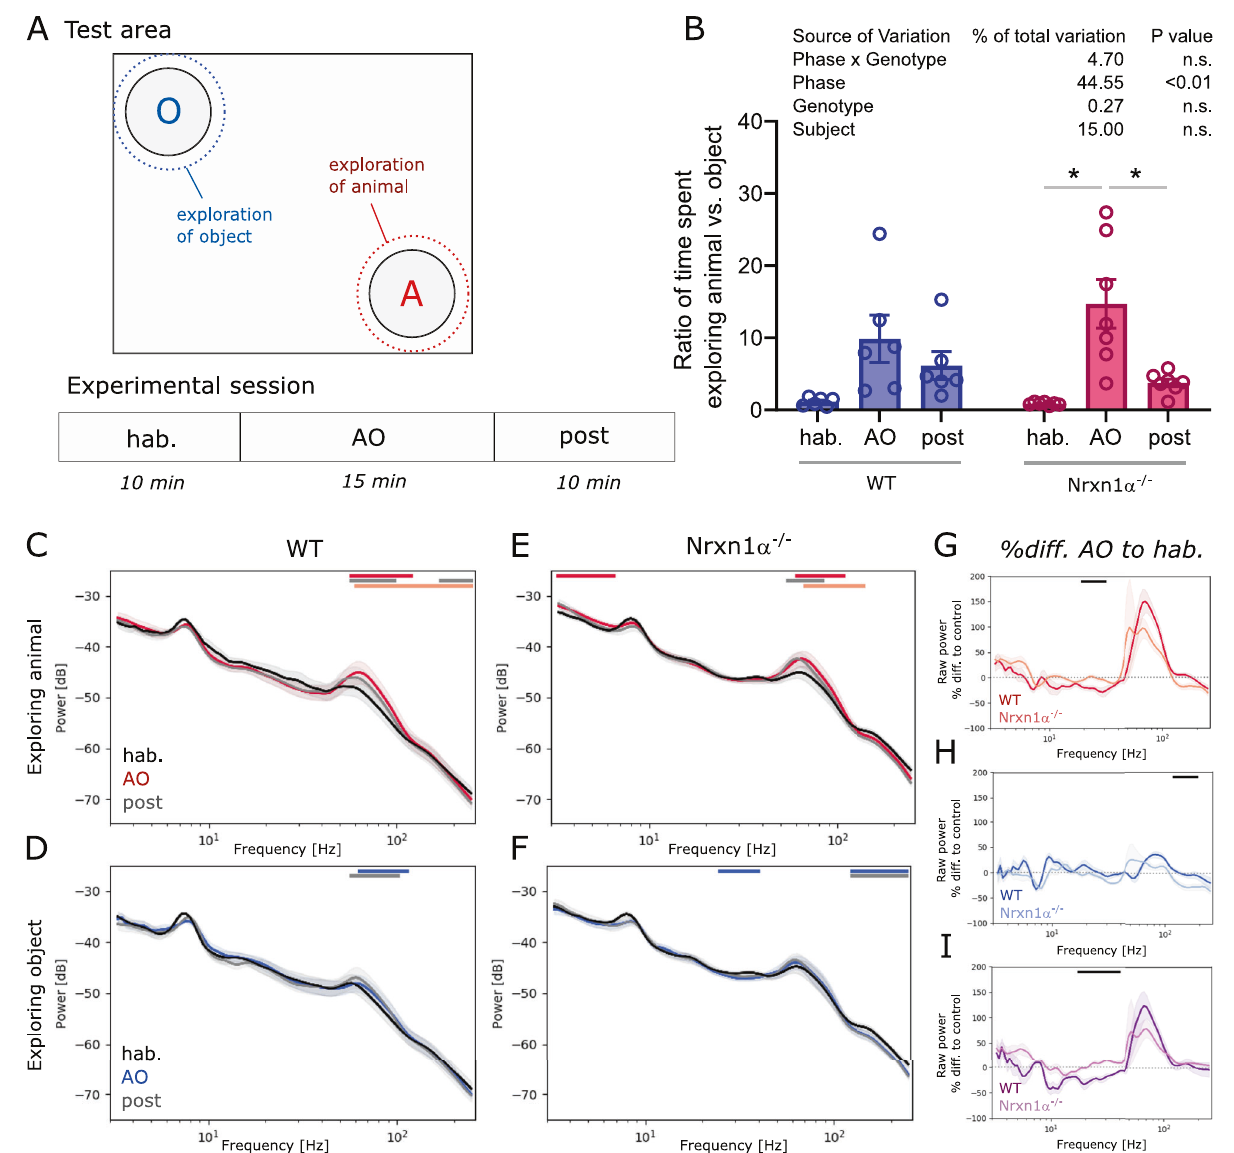
Fig. 5 Behavior and oscillatory activity during social response assay. A Upper part: Schematic of test area, consisting of an open fi eld with an object and an animal zone (rest = neutral zone) with the dotted lines indicating the area in which an encounter is scored as exploration; and lower part: Design of the experimental session (3 phases: habituation, hab; animal/object exploration, AO; post phase). B Box plot showing the ratio of time animals spent exploring the animal compared to exploring the object. Two-way ANOVA with Sidak ’ s multiple comparisons post-hoc test (* p < 0.05). Summary statistics for ANOVA results are displayed above the graphs. C , D Spectral density plots during exploration of the littermate or the object, respectively, for wildtype rats ( N = 6) and E , F for Nrxn1 α − / − ( N = 7). G , H Plots displaying the percentage difference of spectral power during animal or object exploration (normalized to the power during the habituation phase), respectively. I Difference plots between spectral changes during animal exploration shown in G and object exploration shown in H . Data displayed as mean + SEM and tested with paired or unpaired CBPT. Colored bars (red or blue: AO vs. hab; gray: post vs.hab; light red or light blue: AO vs. post; black: WT vs. Nrxn1 α − / − ) above the graphs represent clusters with statistically signi fi cant